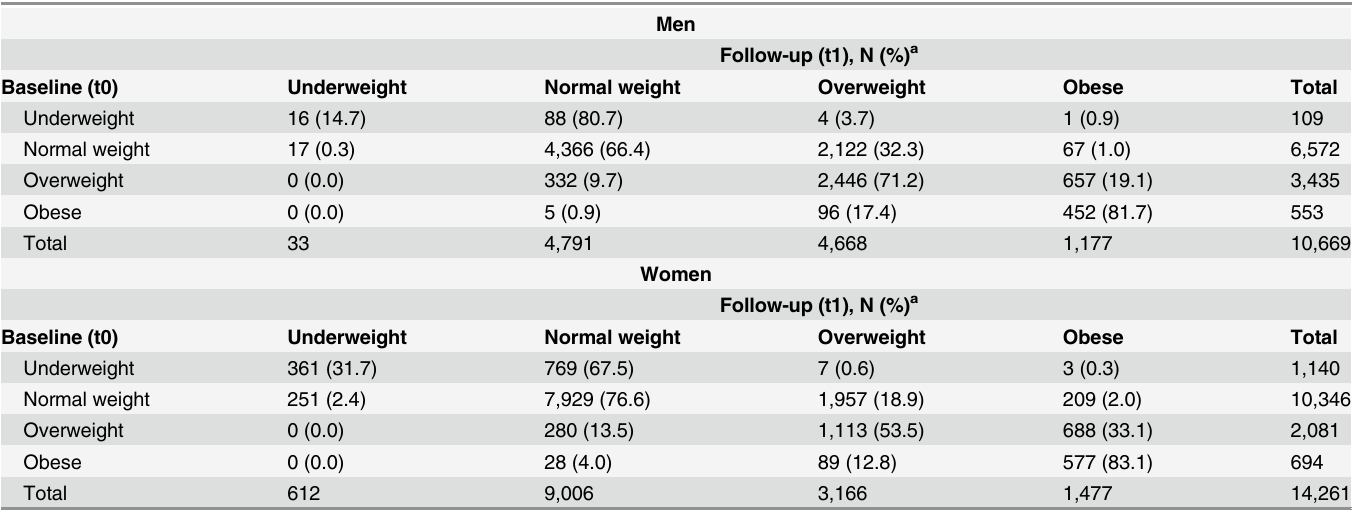
Table 2. Changes in BMI category over 10 years.